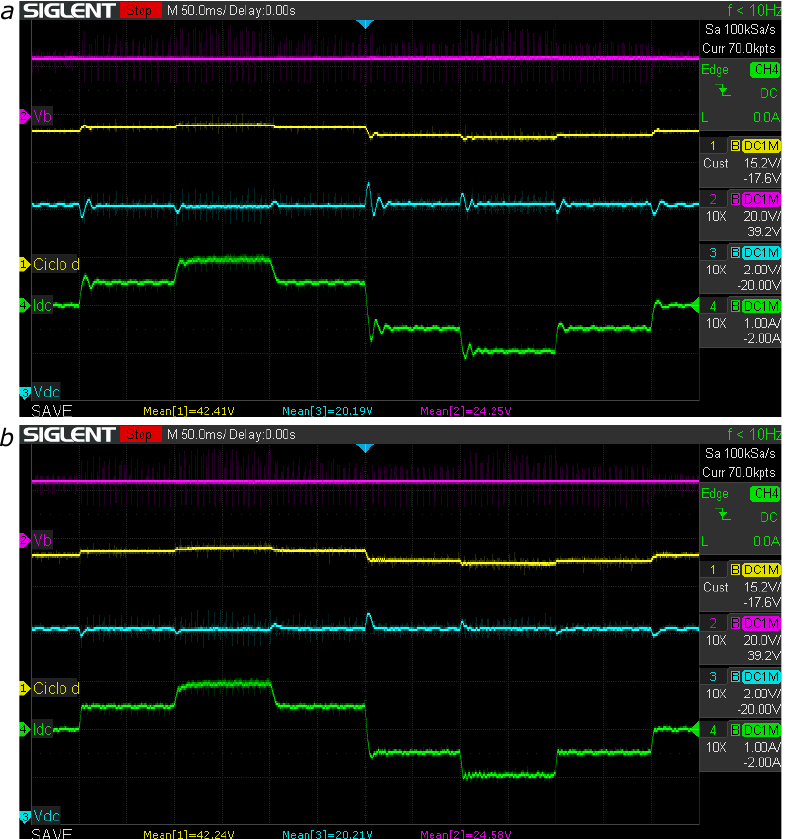
= 20 V (buck mode) using ( a ) PI and ref